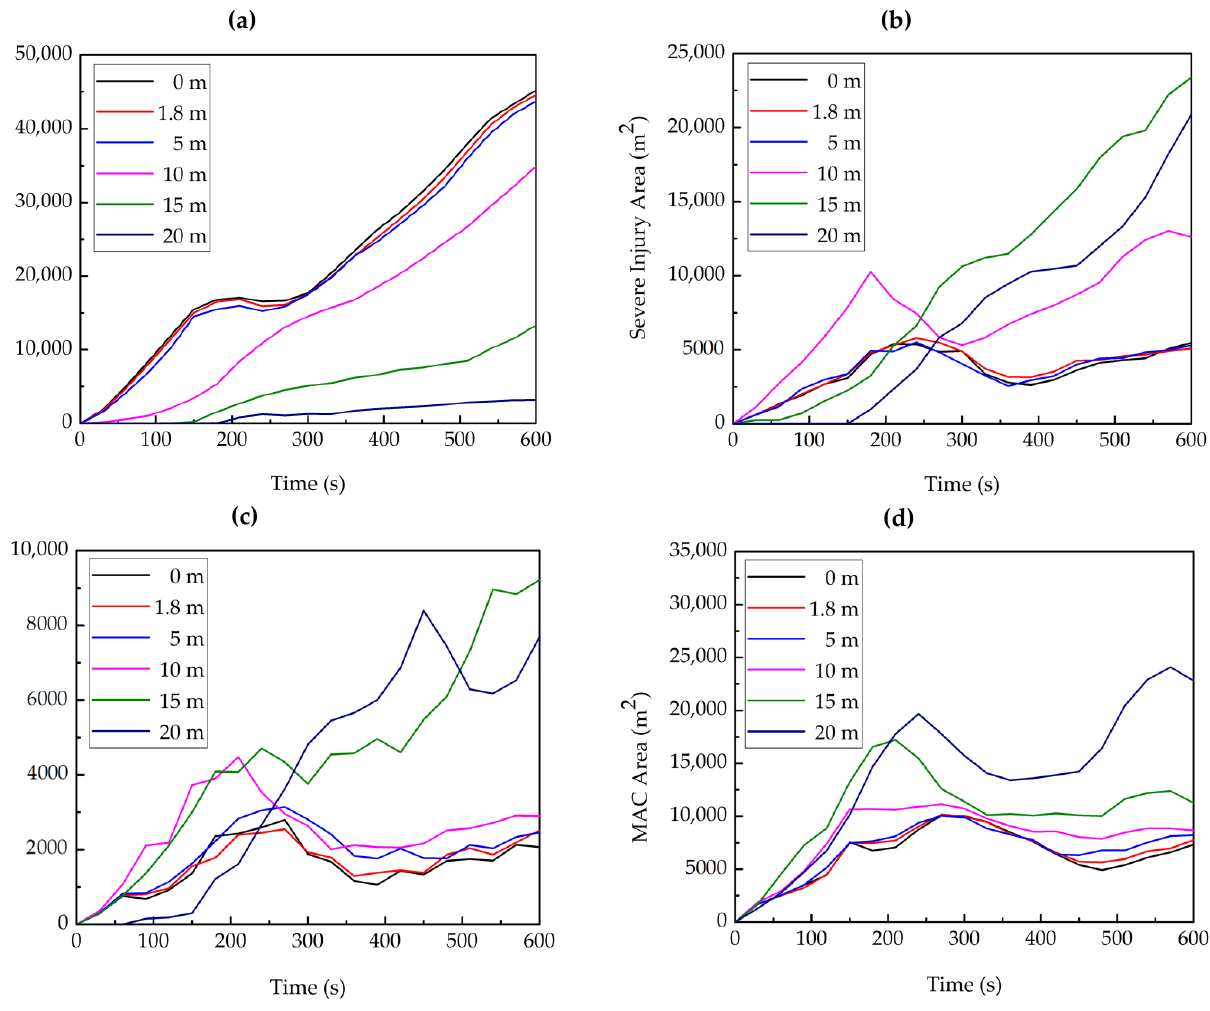
Figure 4. Changes in hazardous areas with time at different heights when the wind speed is 2 m/s: ( a ) lethal area; ( b ) severe injury area; ( c ) light injury area; ( d ) maximum allowable concentration area (MAC area).